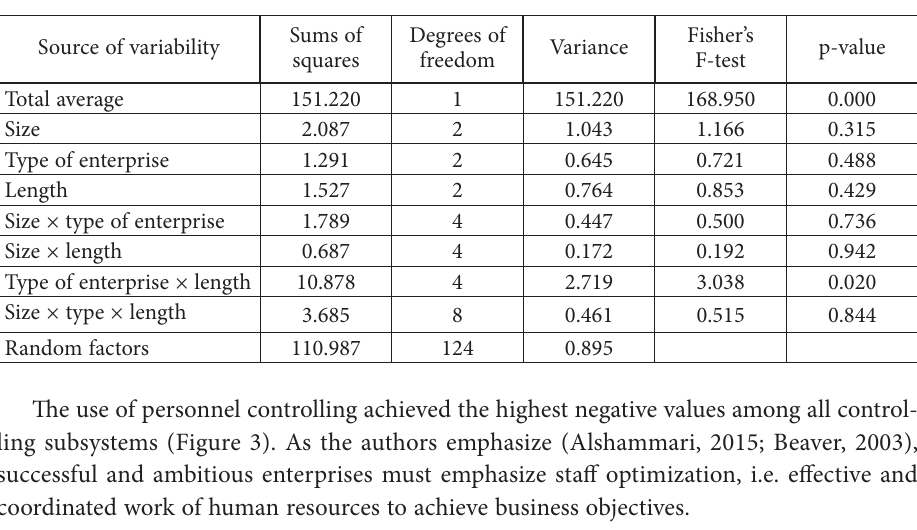
Table 6. Three-factor analysis of variance V5